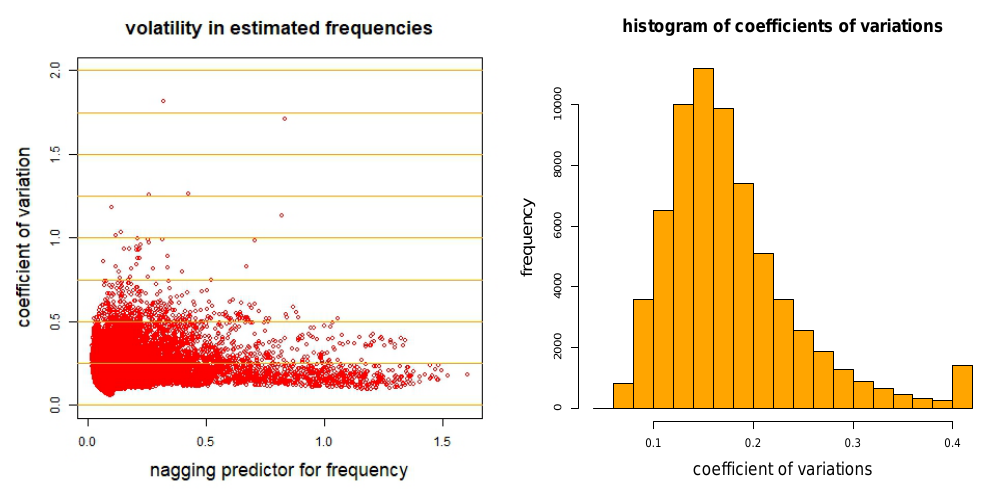
Figure 5. Coefficients of variation (cid:100) CoV t on individual policy predictions t = 1, . . . , m : (lhs) scatter plot ( M ) against nagging predictors ¯¯ µ , and (rhs) t